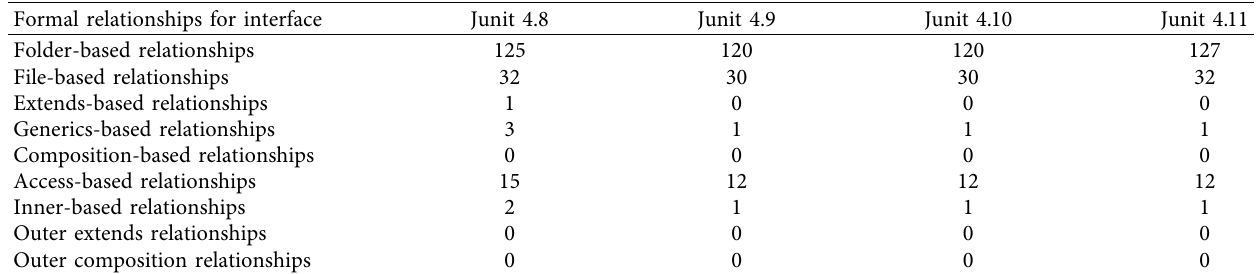
Table 19: Formal relationships for interface in Junit.